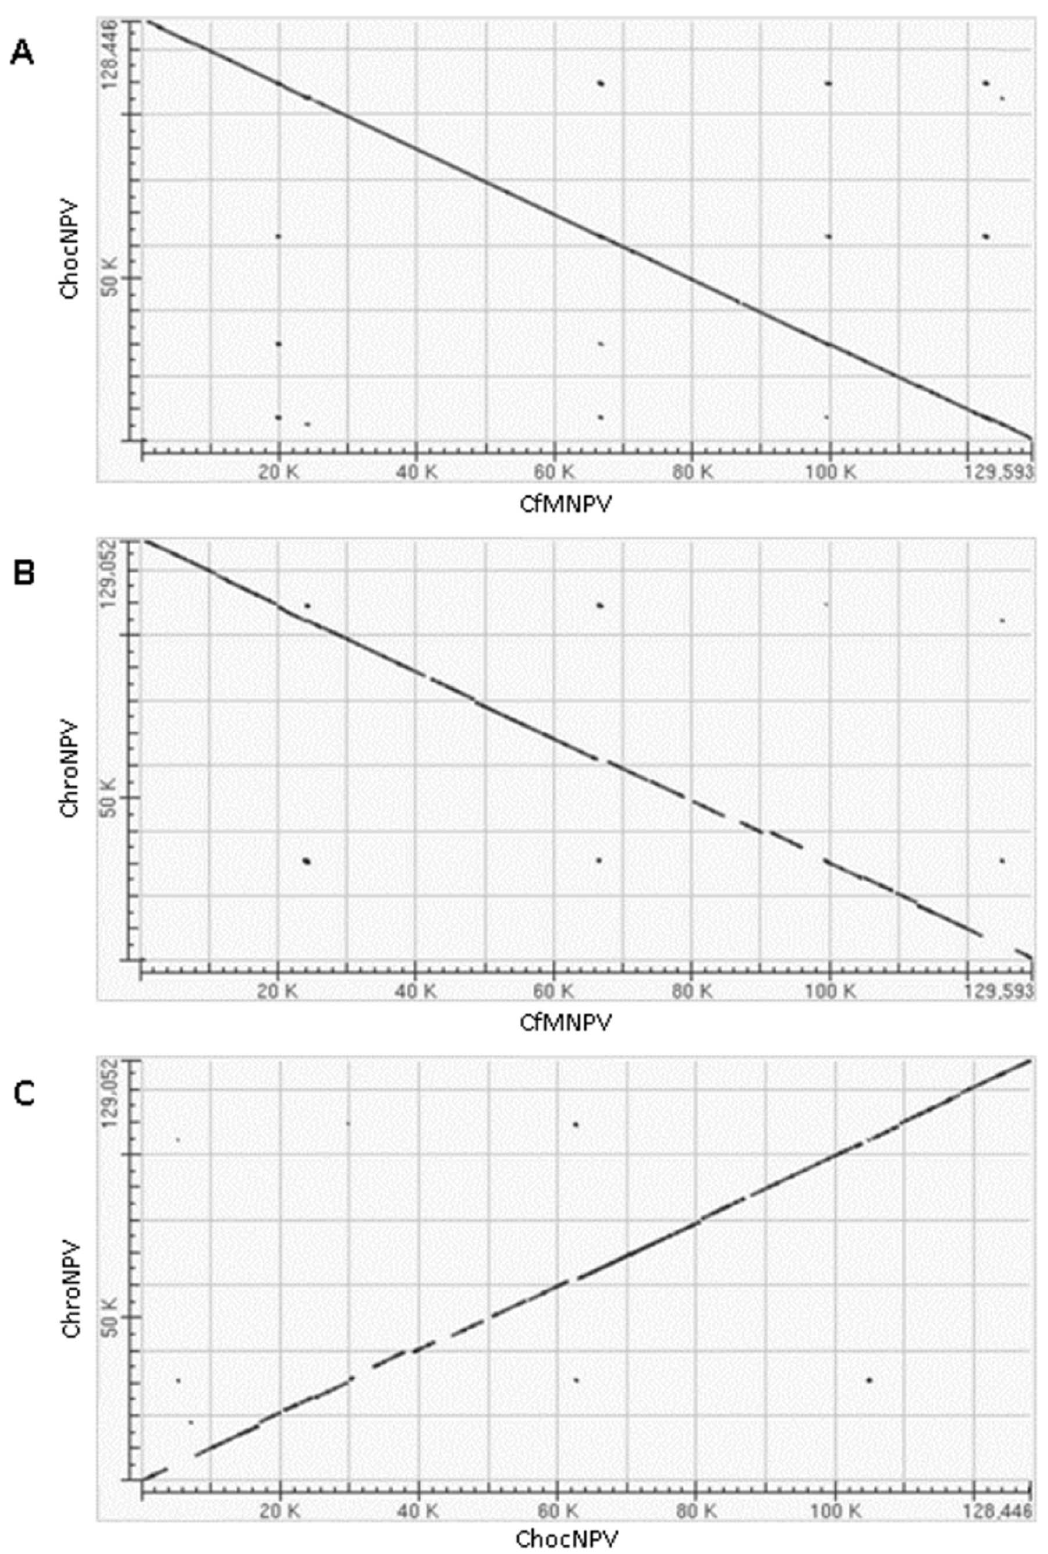
Figure 2. Dot matrix analysis of three Choristoneura NPV genomes. The plots were generated using blastN global genome alignment and compare; A) ChocNPV and CfMNPV, B) ChroNPV and CfMNPV, and C) ChroNPV and ChocNPV genomes. All genomes show a high degree of co- linearity.